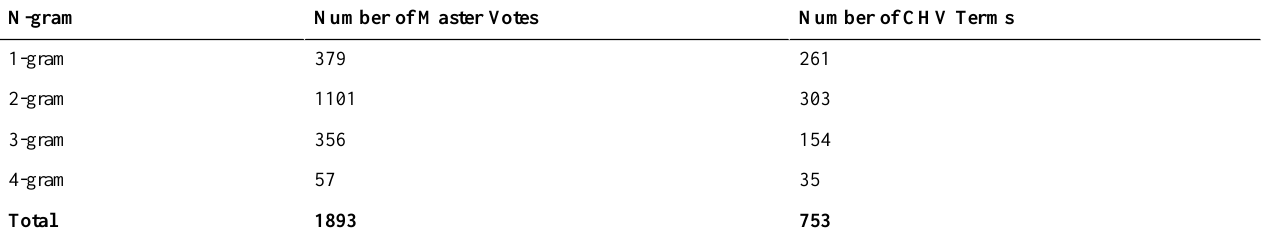
Table 1. Number of n-grams with master votes and number of n-grams voted as CHV terms